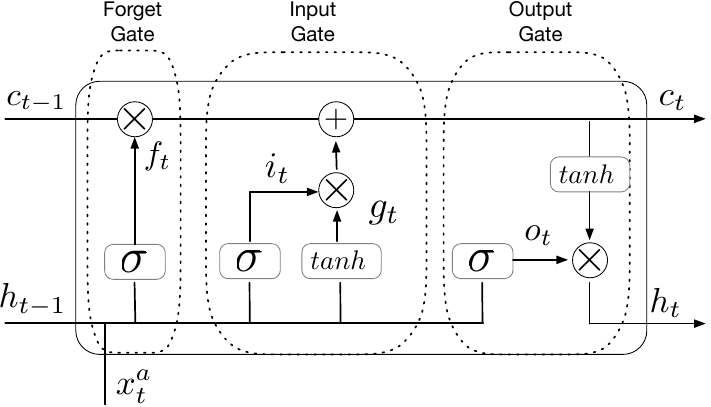
Figure 1. Architecture of an LSTM cell, including forget, input, and output